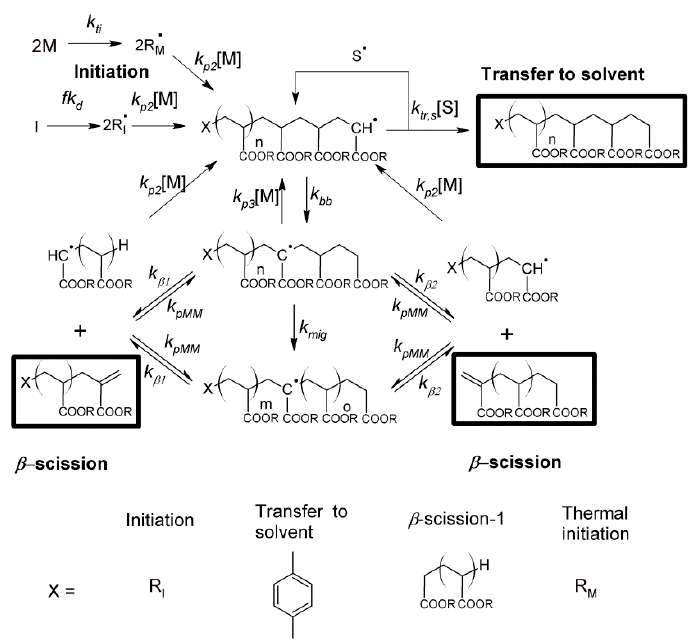
Scheme 1. Reaction pathway in synthesis of alkyl acrylates.